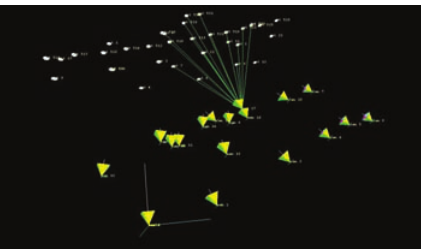
Figure 15: Recovery of camera motion and scene